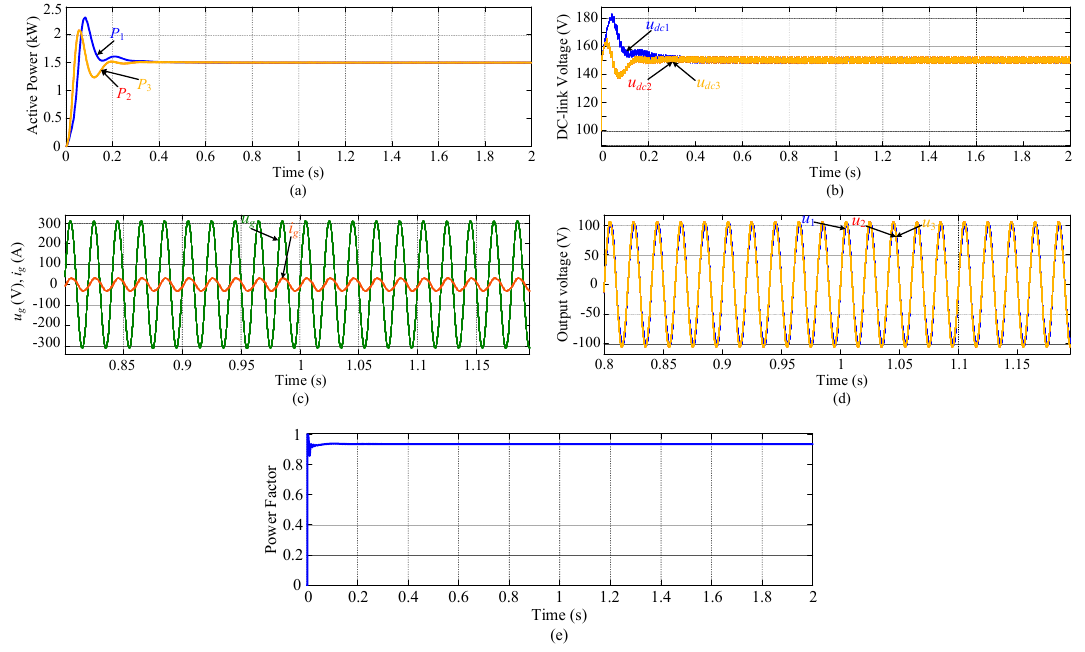
Figure 9. Simulation results under grid frequency fluctuation. ( a ) Active power; ( b ) DC-link voltages; ( c ) Grid voltage and line current; ( d ) Output voltages; ( e ) Power factor (PF). From Figure 9a,b P 1 ~ P 3 are identical and DC-link voltages u dc 1 ~ u dc 3 reach the same steady-state value, which indicates that the system operates under symmetrical condition and achieves MPPT.